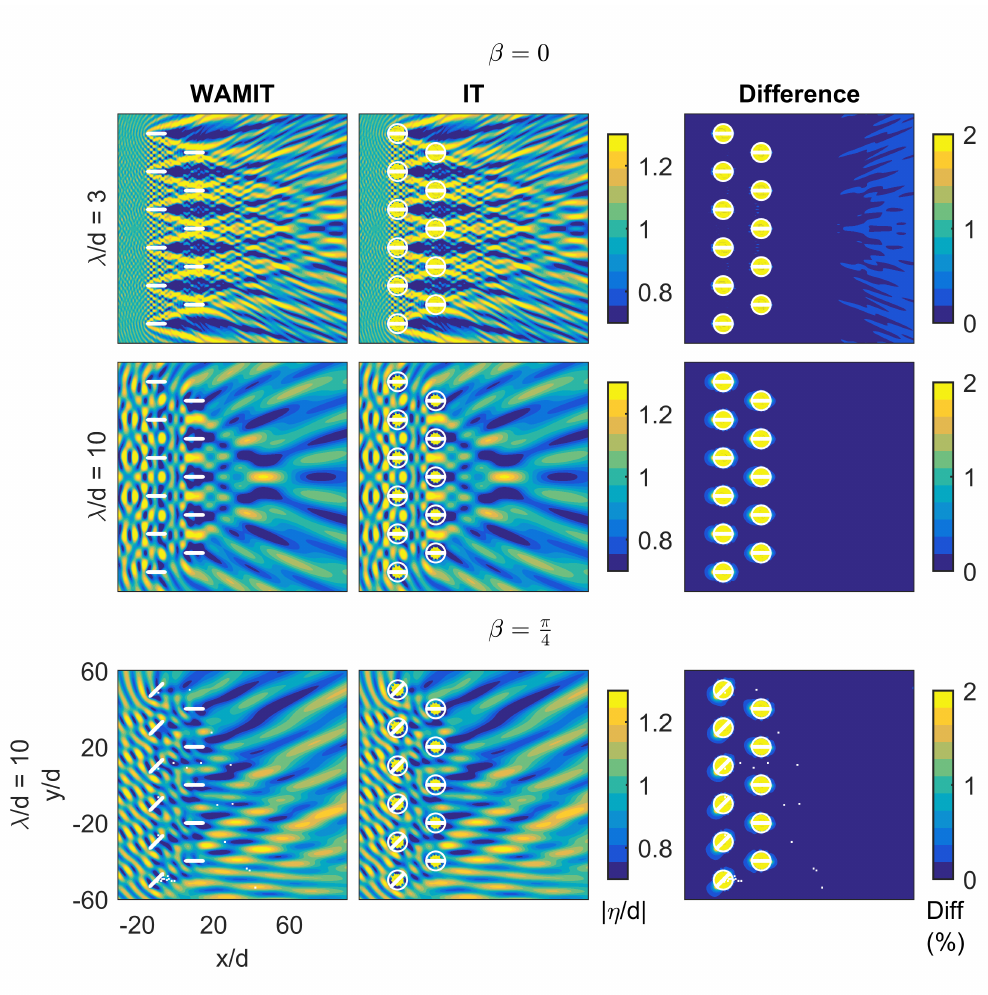
Figure 1. Result of a verification/comparison of linear wave interaction theory (LWIT) computation to a direct computation using WAMIT from McNatt [28].